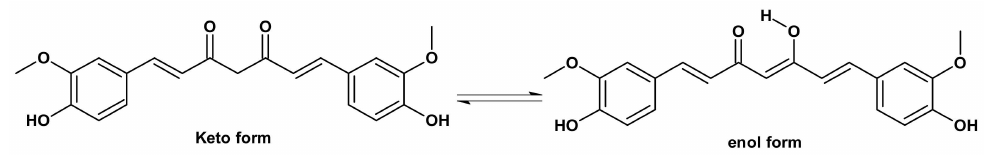
Figure 1. Keto–enol tautomerism of